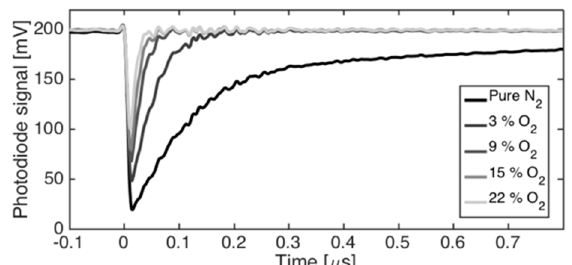
Figure 4. Examples of CPFAAS signal that shows the effect of O 2 environment on the magnitude of signal. a